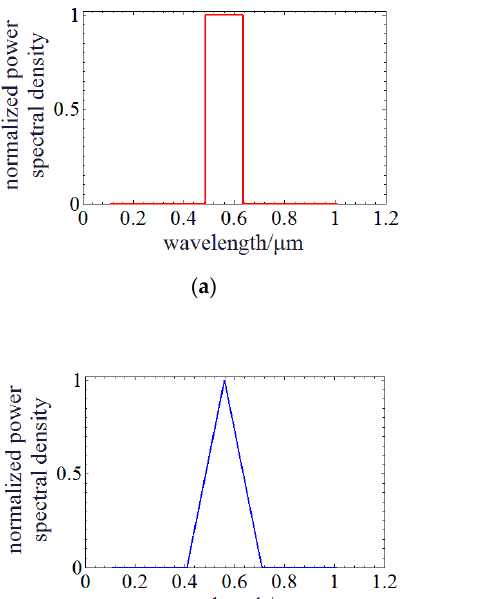
Figure 4. Simulation of PLCI for MADM with a BLS of square and triangular profile: ( a ) The profile of the square BLS; ( b ) Relationship between envelope and zero ‐ order PLCIF peak center when BLS is in square profile; ( c ) The profile of the triangular BLS; ( d ) Relationship between envelope and zero ‐ order PLCIF peak center when BLS is in triangular profile.